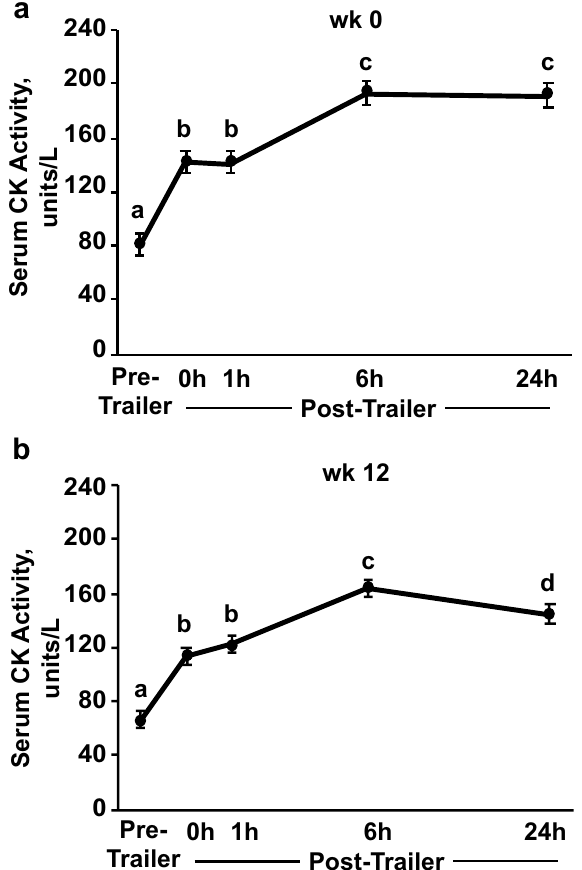
Figure 2. Serum creatine kinase (CK) activity before (Pre-Trailer), and 0, 1, 6, and 24 h after (0 h, 1 h, 6 h, and 24 h, respectively) a 1.5-h trailer stressor. Trailer stressors occurred before (week 0; a ) and after (week 12; b ) 12 weeks of submaximal exercise training in yearling horses (n = 16). Due to lack of effect of diet, dietary treatments have been combined. Overall effect of trailering ( P < 0.0001; P < 0.0001) for panels a and b , respectively. a–d Time points lacking common letters differ ( P ≤